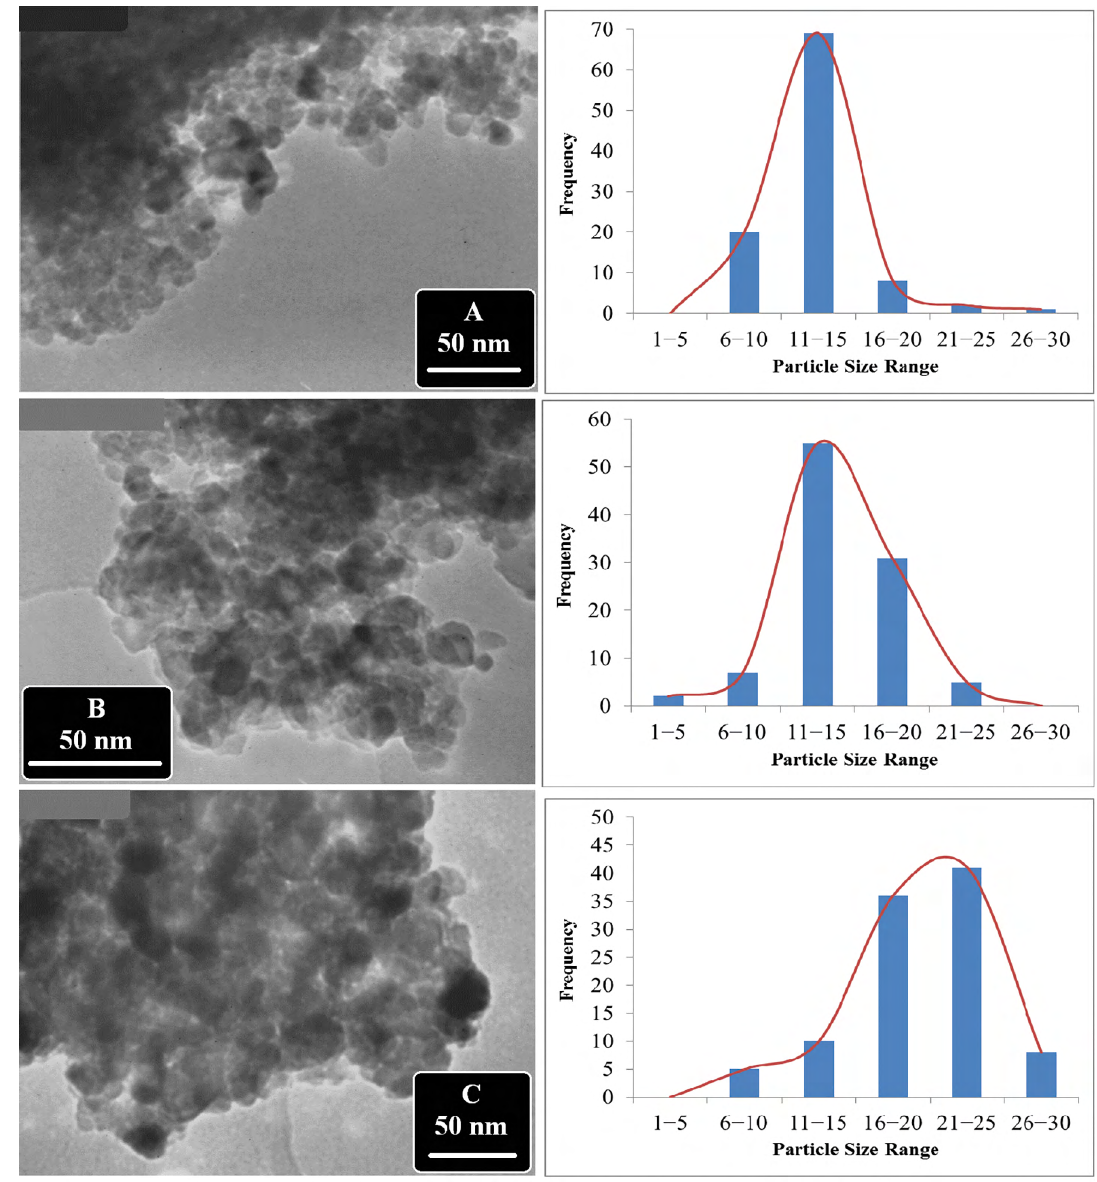
Figure 1. TEM images and histograms of size distribution of the synthesized pigments (A) α-NZF, (B) β-NZ,F and (C)